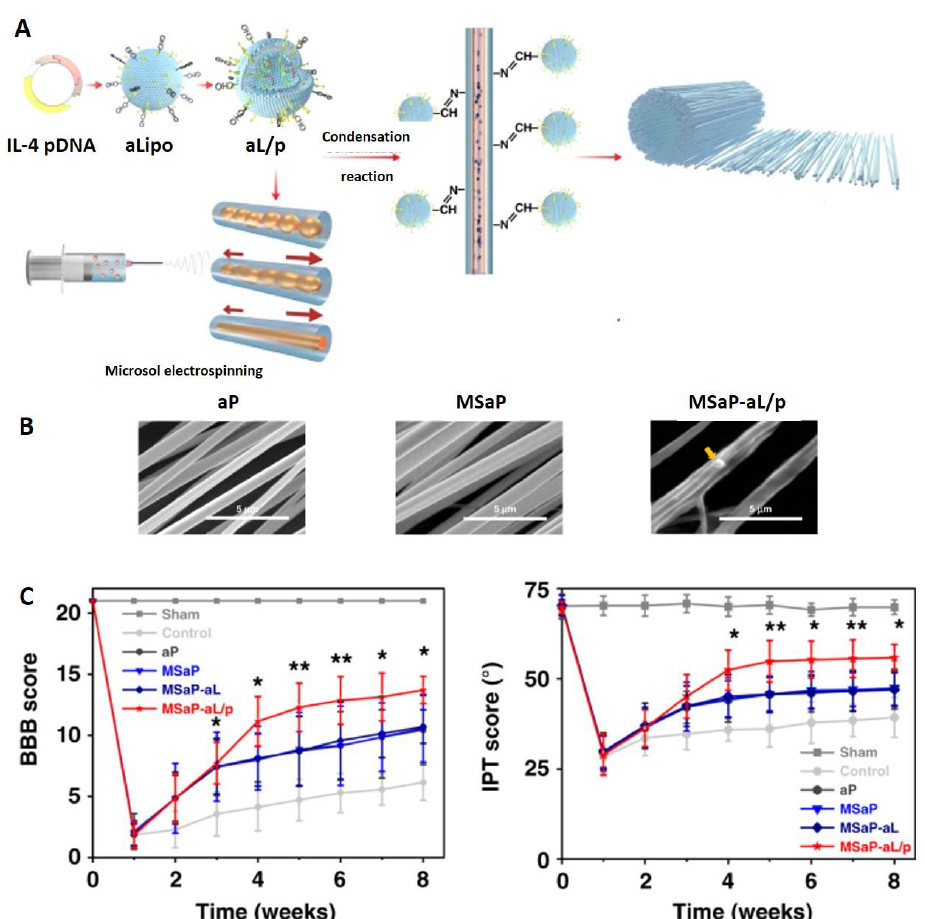
Figure 4. Combination neuron therapy by NF: ( A ) Construction of oriented fiber scaffold loaded with nerve growth factor by microsol electrospinning is followed by condensation with pDNA-loaded liposomes. ( B ) Morphology of different NF scaffolds (aP: amino PLA NF; MSaP: aPLA microsol fibers; MSaP-aL/p: MSaP conjugated with pDNA-loaded liposomes where the yellow arrow indicates the position of liposome). ( C ) Evaluation of motor function recovery by BBB and IPT scores. * p < 0.5, ** p < 0.01. Adapted from [9]. Copyright © 2020, The Author(s) under CCBY